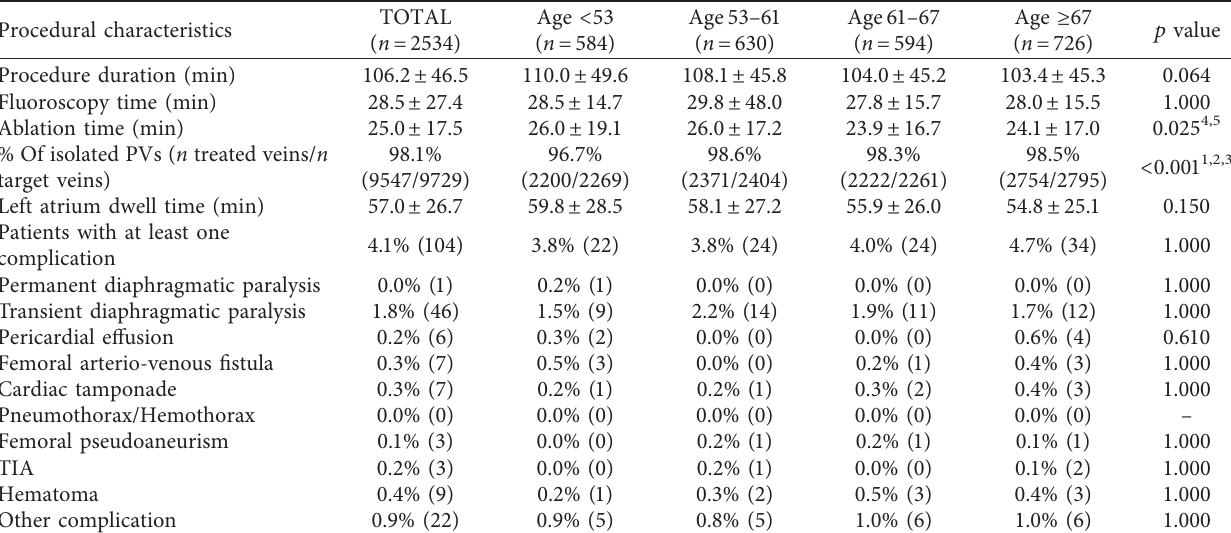
Figure 1: Quartiles of age distribution over enrolling years are presented. A trend toward wider indications in patients ≥ 67 years between 2015 and 2017 can be appreciated. However, no statistically significant differences were found in terms of age distribution ( p � 0 . 567). Data of 2018 were not analyzed, since the database freeze was performed in September 2018. Table 2: Procedural and safety characteristics ( N � 2534) by age groups divided into